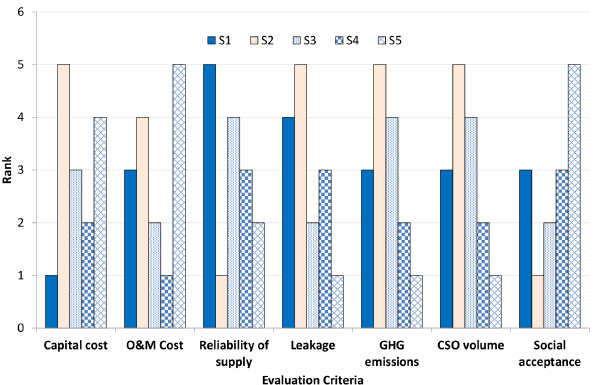
Figure 6. Ranking of the five intervention strategies (S1–S5) with respect to each of the evaluation criteria